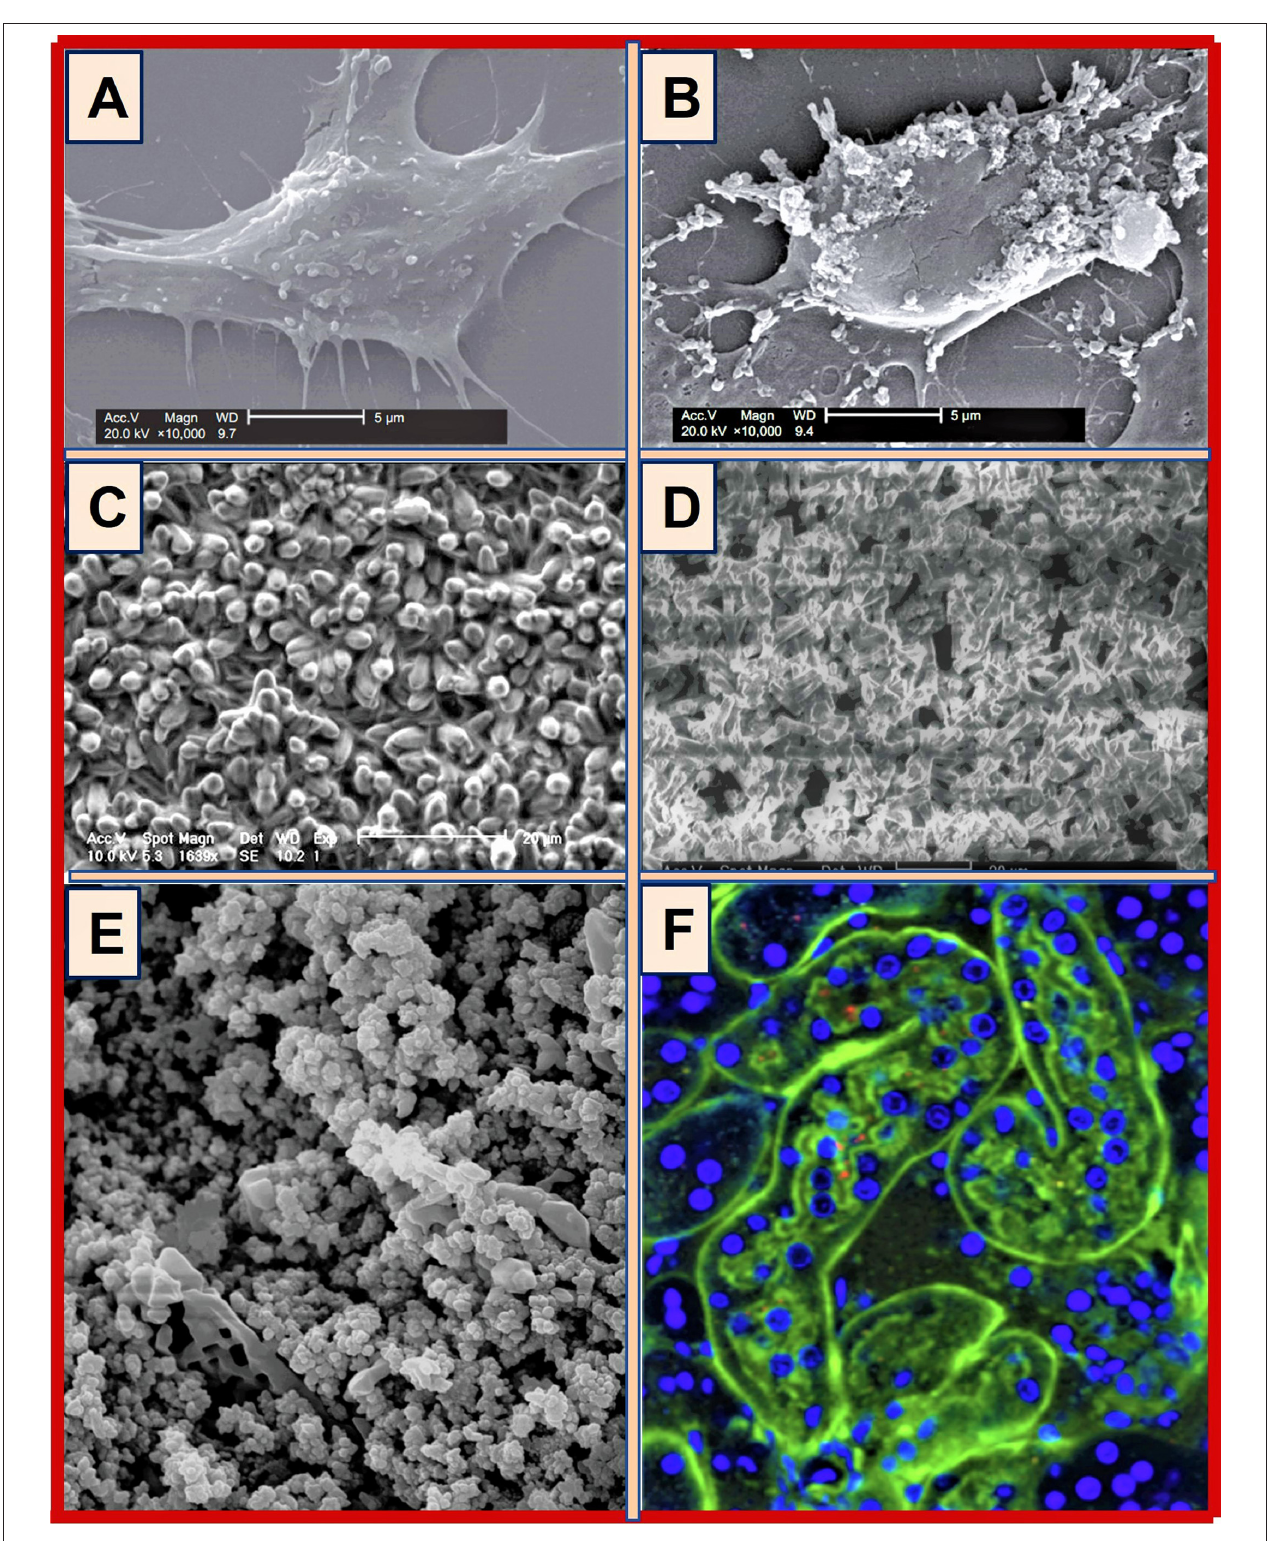
FIGURE 2 | Examples of hydroxyapatite and fluorapatite crystals: (A) CaPO 4 -crystal formation on the surface of Vero cells treated with H 2 O 2 – (A) control; (B) 0.5 mmol/l, H 2 O 2 treatment (scale bars: 5 µ m) [COD, calcium oxalate dihydrate; SEM, scanning electron microscopy] (modeled from Gan et al., 2016); (C) SEM images of fluorapatite crystal growth on etched titanium surface; (D) Random growth of fluorapatite crystals on glass (adapted from Czajka-Jakubowska et al., 2009); (E) SEM image of hydroxyapatite in aqueous solution (after Arnich et al., 2003); (F) CaPO 4 nano-crystals in renal tissue and tubular cells in mice [CaPO 4 crystals in tube lumens (green; FITC-dextran); cell nuclei (blue; Hoechst)] (after Shiizaki et al., 2021).